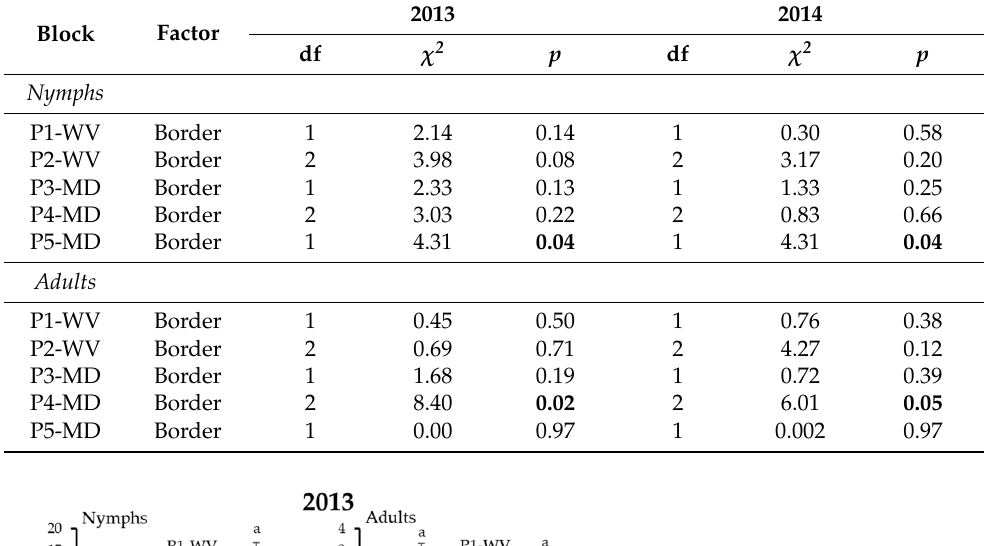
Table 4. Summary of statistical results for captures of H. halys nymphs and adults in pheromone- baited traps on the edges of 5 peach blocks in the Mid-Atlantic, USA, in 2013 and 2014. Significant p values are highlighted in bold font.